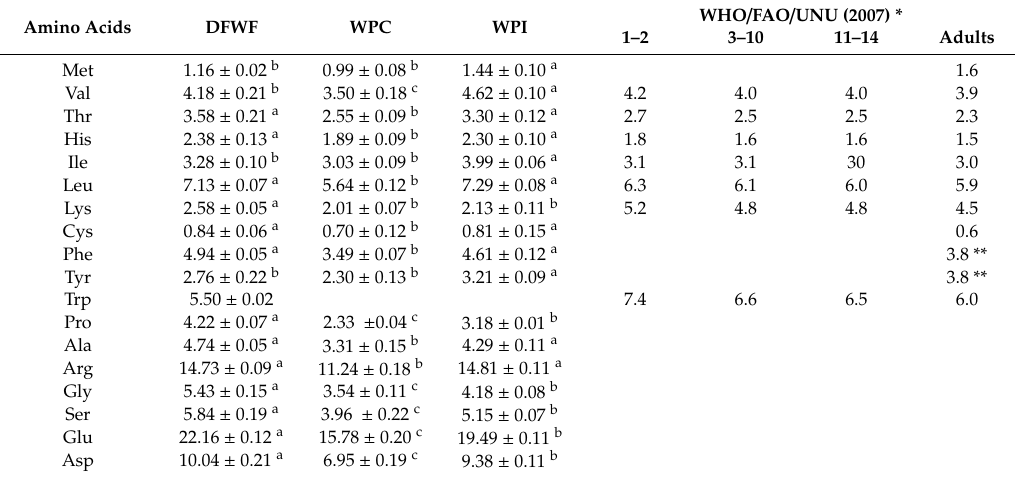
Table 1. Amino acid composition (g / 100 g) of degreased walnut powder and walnut protein [13,15,16]. Amino Acids DFWF WPC